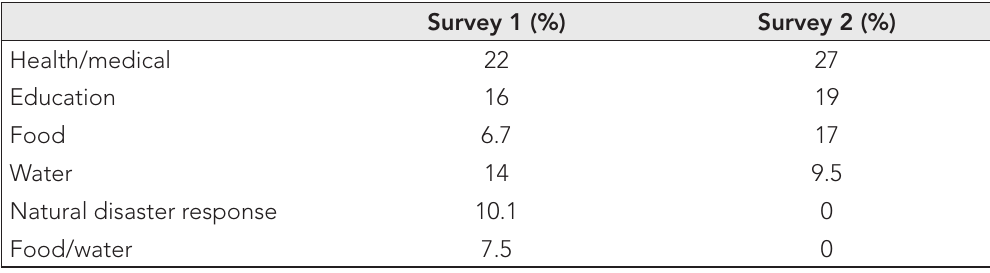
Table 4: Highest priorities for global development aid (according to first